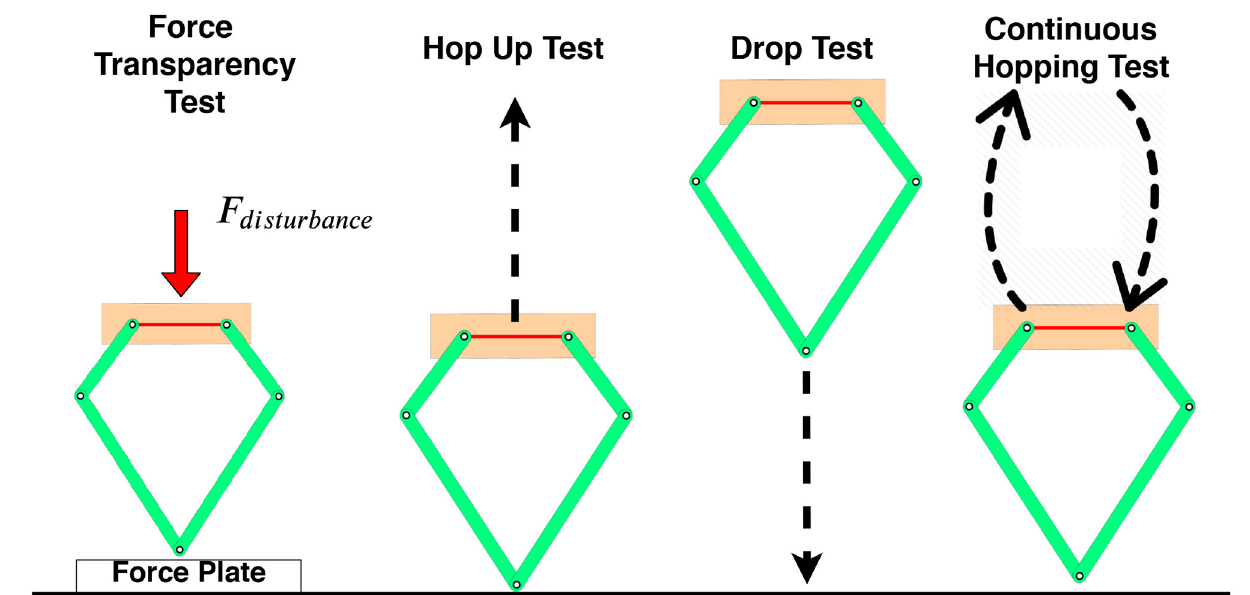
FIGURE 7 | Image showing the four experiments performed on the robot. The first was a force transparency test, where an external force was applied to the robot which was standing on a force plate. The second test was a hop up test followed by a drop test. The fourth test was a continuous hopping